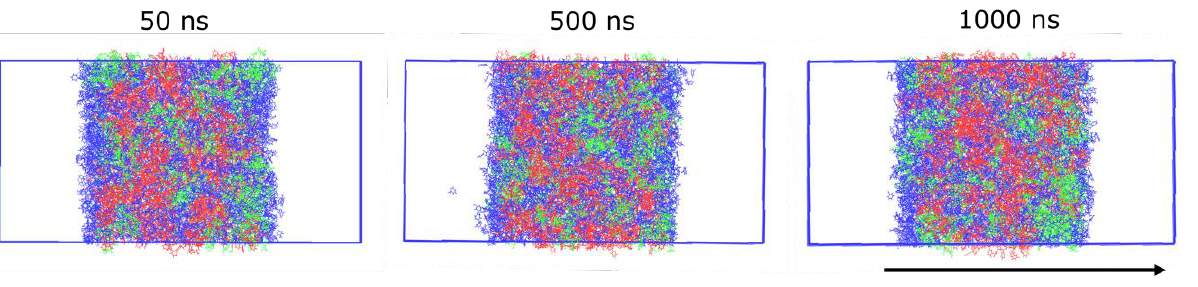
Figure 7. Configurations of the system containing 50 w/w% toluene at 300 K at 50, 500, and 1000 ns. Owing to the applied periodic boundary condition, there are two bulk/vacuum interfaces in our simulation box. (Red: aPS, blue: toluene, and green: